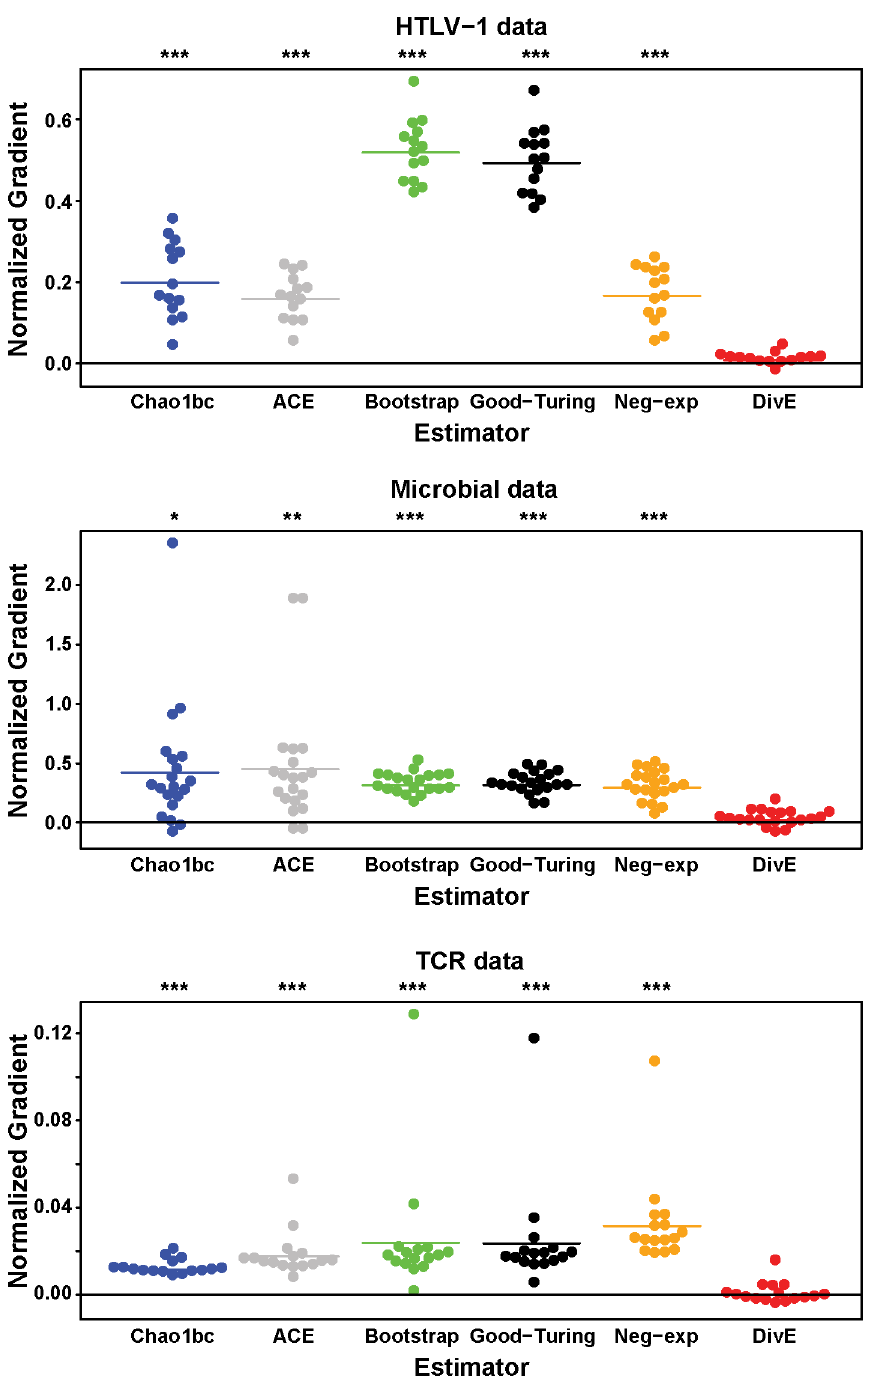
Figure 4. Comparison of estimators: Effect of sample size on estimated diversity. Normalized gradients measuring proportional increase in estimated diversity against proportional increase in sample size. Normalized gradients (shown for each estimator and each patient data set in Table S1) were calculated by linear regression. For the HTLV-1 and microbial data, all estimators except DivE show large normalized gradients that are significantly positive. The TCR normalized gradients, though significantly positive, are small and do not show a substantial bias with sample size. *, **, and *** signify p , 0.01, p , 0.001, and p , 0.0001 respectively; two-tailed binomial test (n=14, 16, 20 for the HTLV-1, TCR and microbial data